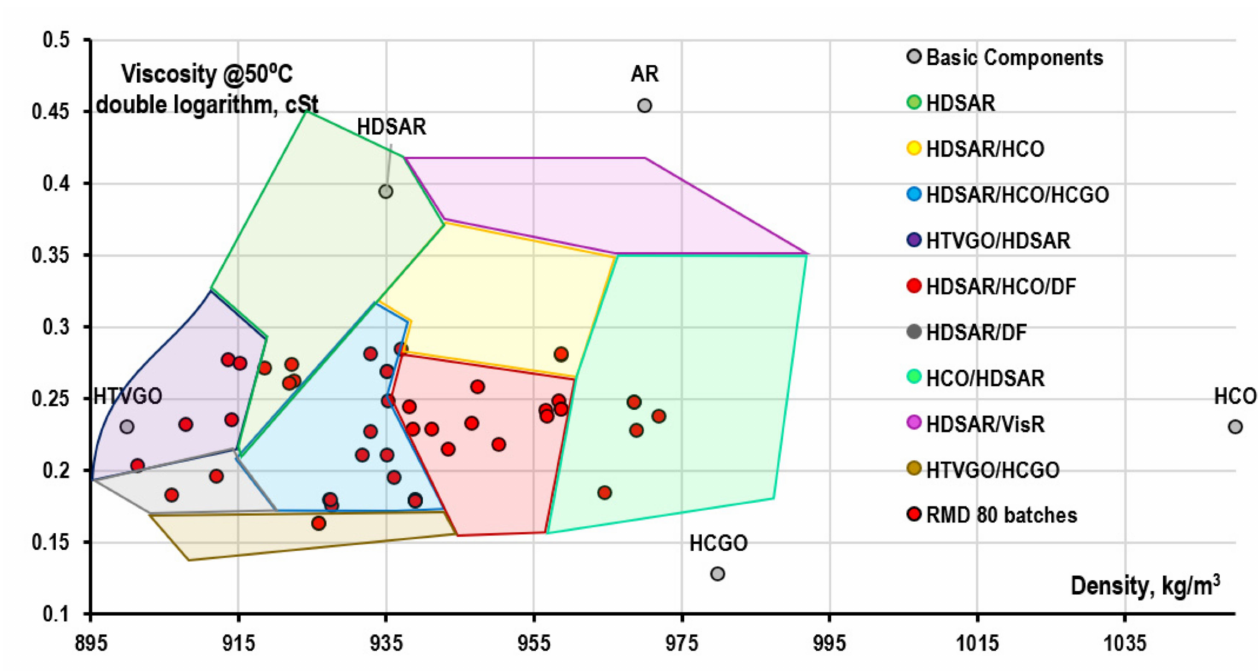
Figure 25. RMD 80 batches in logarithmic coordinates [97]. Table 17. Distribution of RMD batches of 80 world ports by type